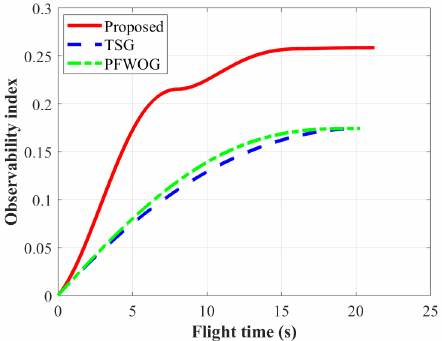
Figure 4. Observability index under different guidance laws.